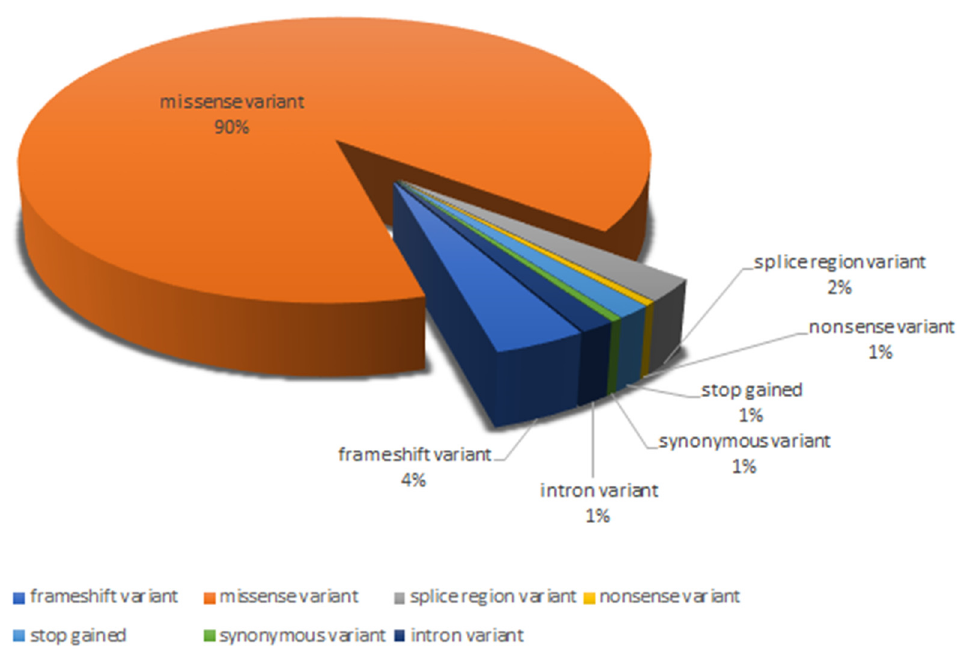
Figure 2. Distribution of the different variant types analyzed .